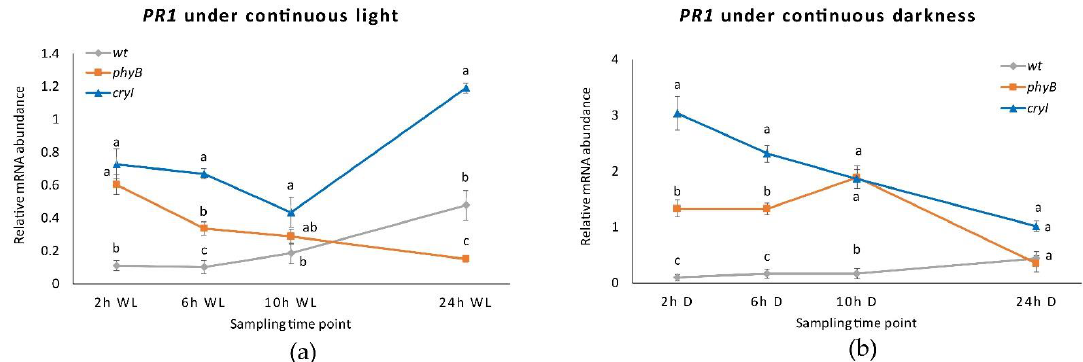
Figure 8. PR1 expression in Dar Gazi-wt , Dar Gazi-phyB , and Dar Gazi-cry1 : ( a ) in 24 h continuous light, panel; ( b ) in 24 h continuous darkness. Results are presented after normalization with ef1A . Data shown as the average of two biological replicates run in triplicate, with error bars representing SD. At each time point, values with different letters significantly differ according to the analysis of variance (ANOVA) and least significant difference (LSD) tests ( p ≤ 0.05).